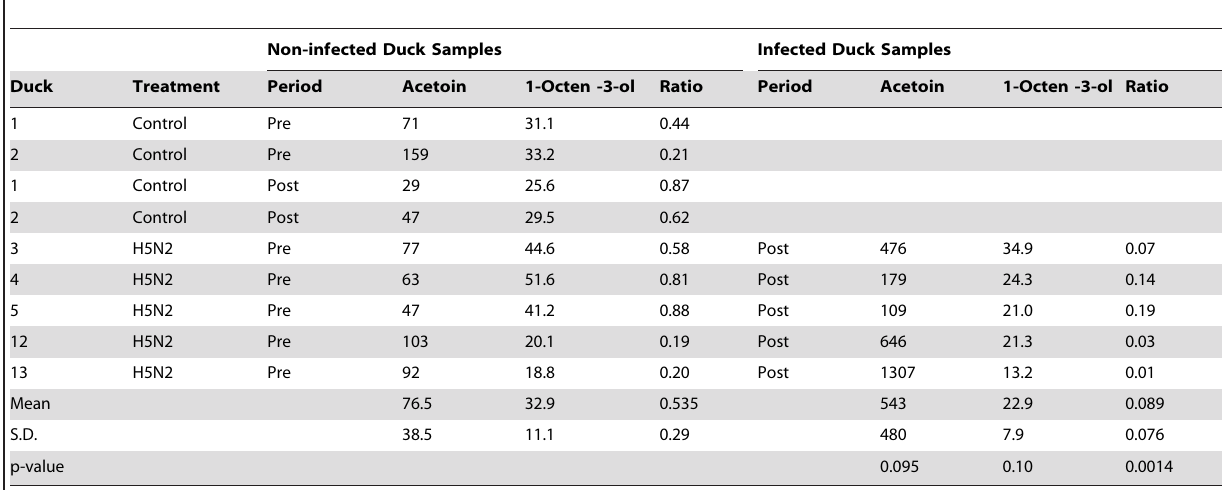
Table 5. Peak area responses ( 6 10 5 ) of acetoin and 1-octen-3-ol determined in ethanol extracts of duck